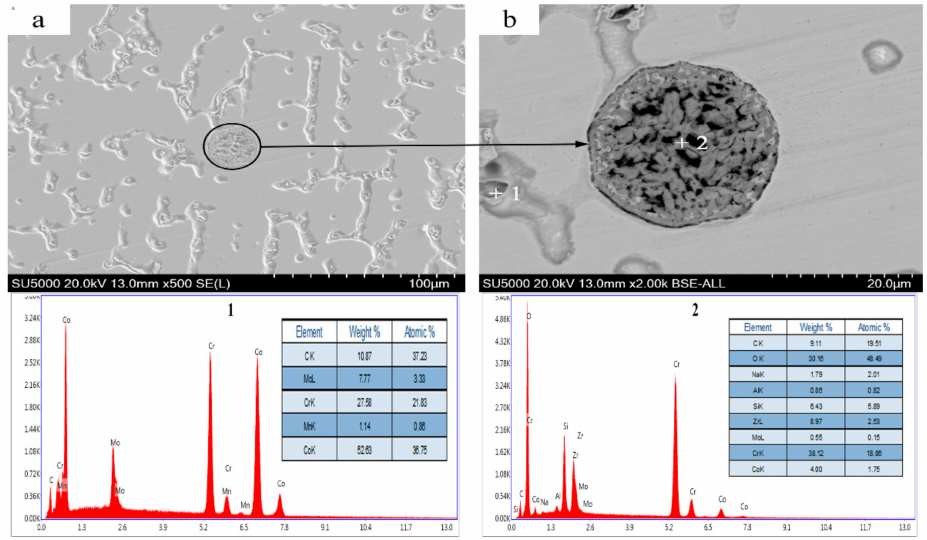
Figure 9. Microstructural analysis of 10% Al 2 O 3 sample. ( a ) Microstructure of Al 2 O 3 alloy with 10% Al 2 O 3 content; ( b ) partial enlargement of microstructure.